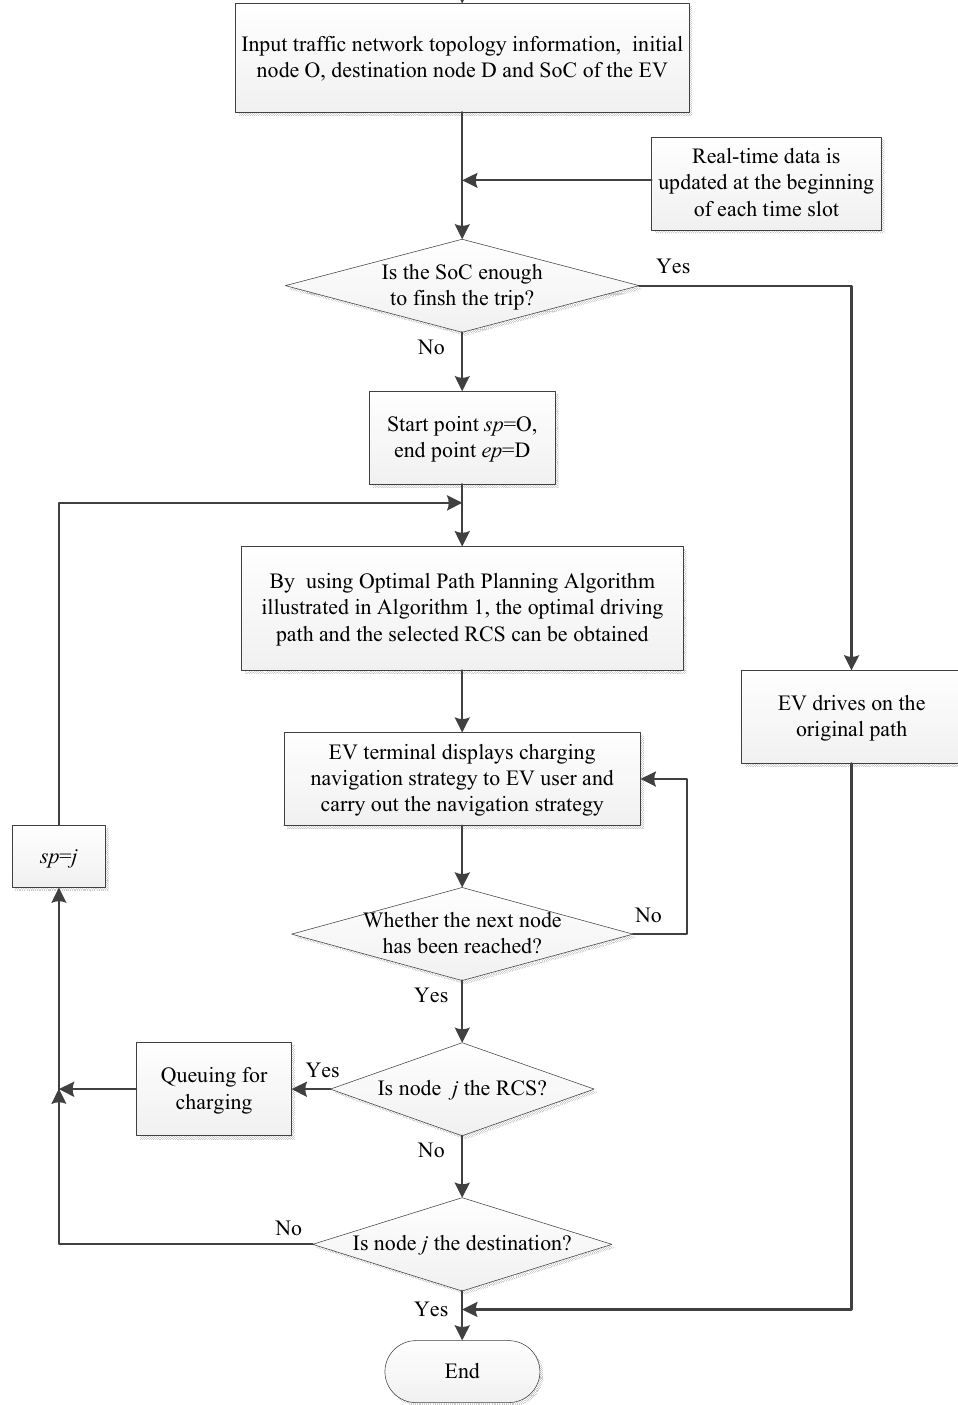
Figure 5. Solution procedure of optimal rapid-charging